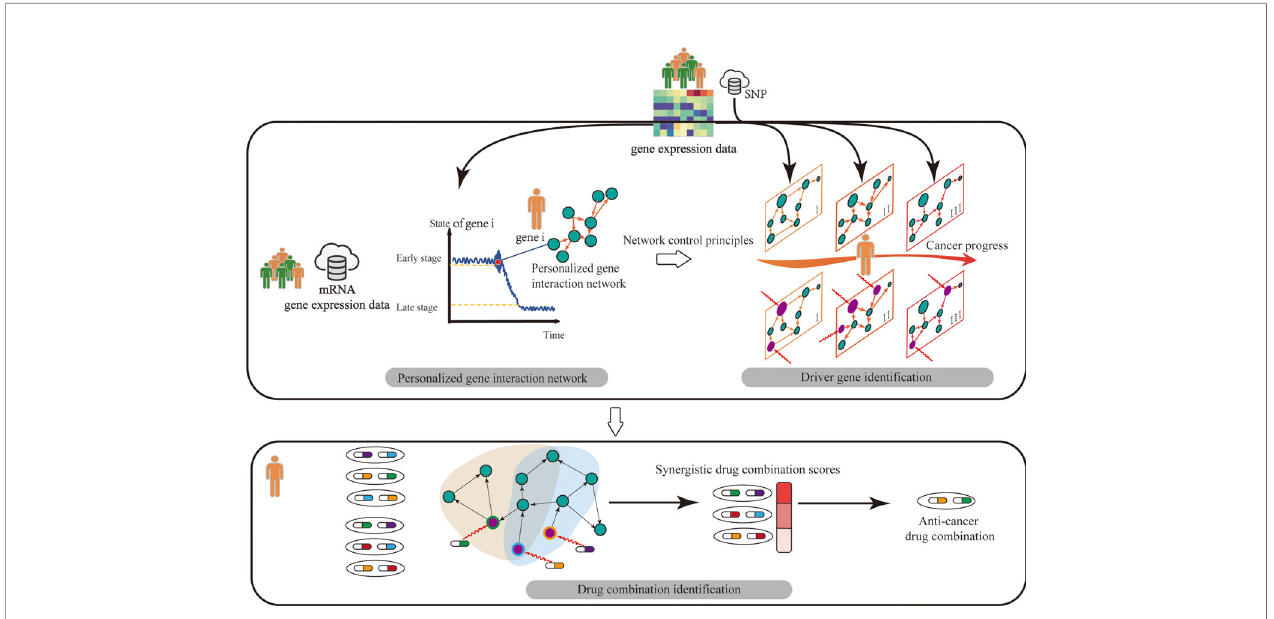
FIGURE 1 | Overview of our review. The contents of our review consist of three parts. Firstly, we summarized the works to construct personalized gene interaction network from genomics of individual patients. Then on the personalized gene interaction networks, we pointed out how to identify personalized driver gene by using network control tools. Finally, we described how to discover synergistic drug combinations by targeting personalized driver